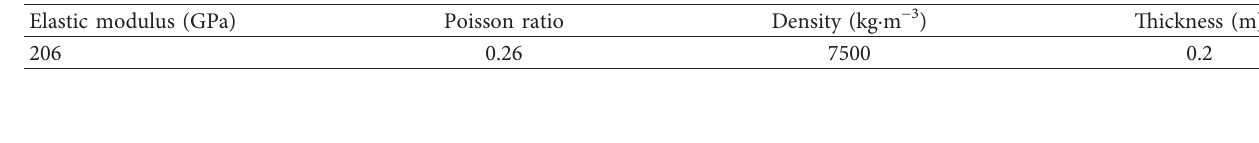
Table 4: Parameters for U-type steel.